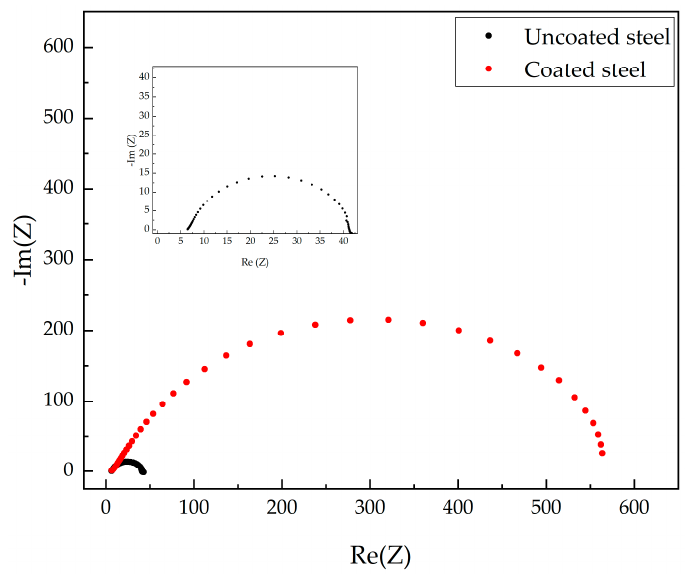
Figure 5. Nyquist plot of mild steel in 0.1 mol L − 1 HCl with and without the coating of Artemisia vulgaris extract.